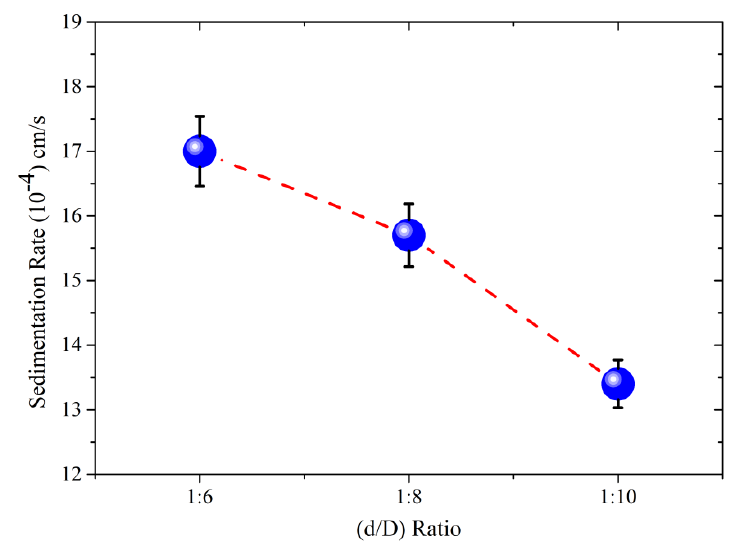
Figure 5. Effect of d/D ratio on sedimentation rate of BaFe 11.2 Mg 0.4 Al 0.4 O 19 .